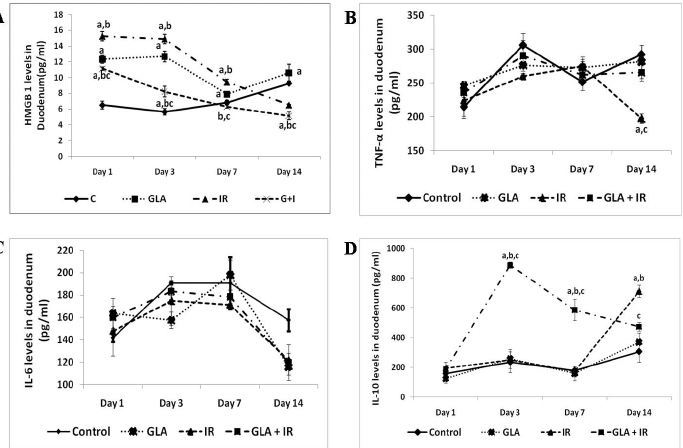
Figure 11. Estimation of duodenal concentrations of cytokines HMGB1 ( A ), TNF- α ( B ), IL-6 ( C ), and IL-10 ( D ) by ELISA method. Mice were pre-treated with 100 μ g/kg GLA at 48, 24, and 1 h prior to irradiation, and were subjected to total-body irradiation of 7.5 Gy (at 1 Gy/min). Duodenum samples were obtained on day 1, day 3, day 7, and day 14 post-irradiation. All values are expressed as mean ± SEM (n = 3). Statistical significance was calculated using t -tests, and p -values < 0.05 are represented by a , b , c when compared to control, GLA, and irradiation, respectively. C, control; GLA, gamma- linolenic acid; IR, irradiation (7.5 Gy).